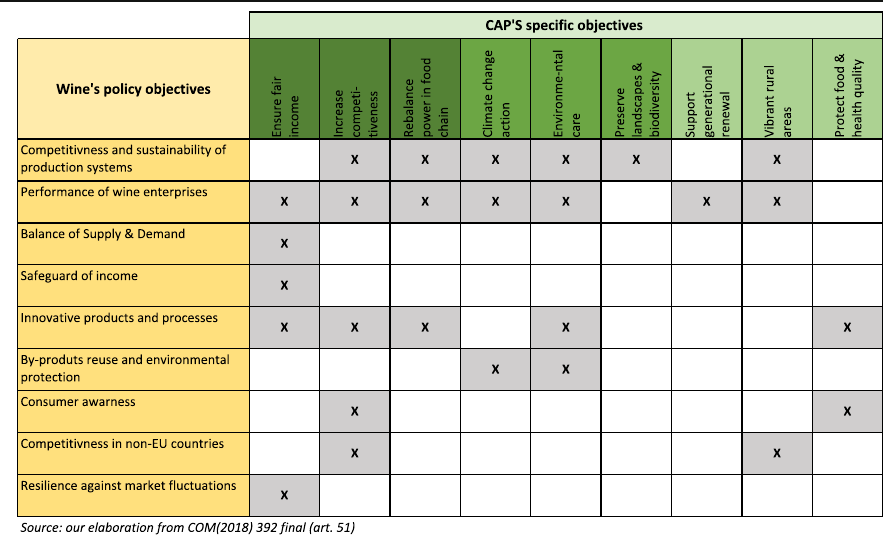
Table 8 New CAP and wine policy objectives (2021 – 2027)